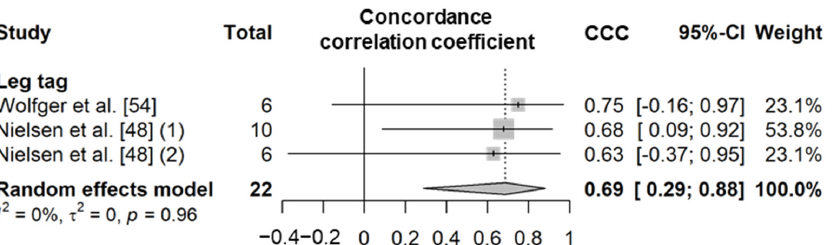
Figure 9. Forest plot of the concordance correlation coefficient of step counts between wearable sensors and visual observation. Numbers in parentheses indicate individual studies applying different evaluation conditions within the same article. ‘Total’ means the sample size of each study and ‘Weight’ means the weight for the mean based on the sample size.